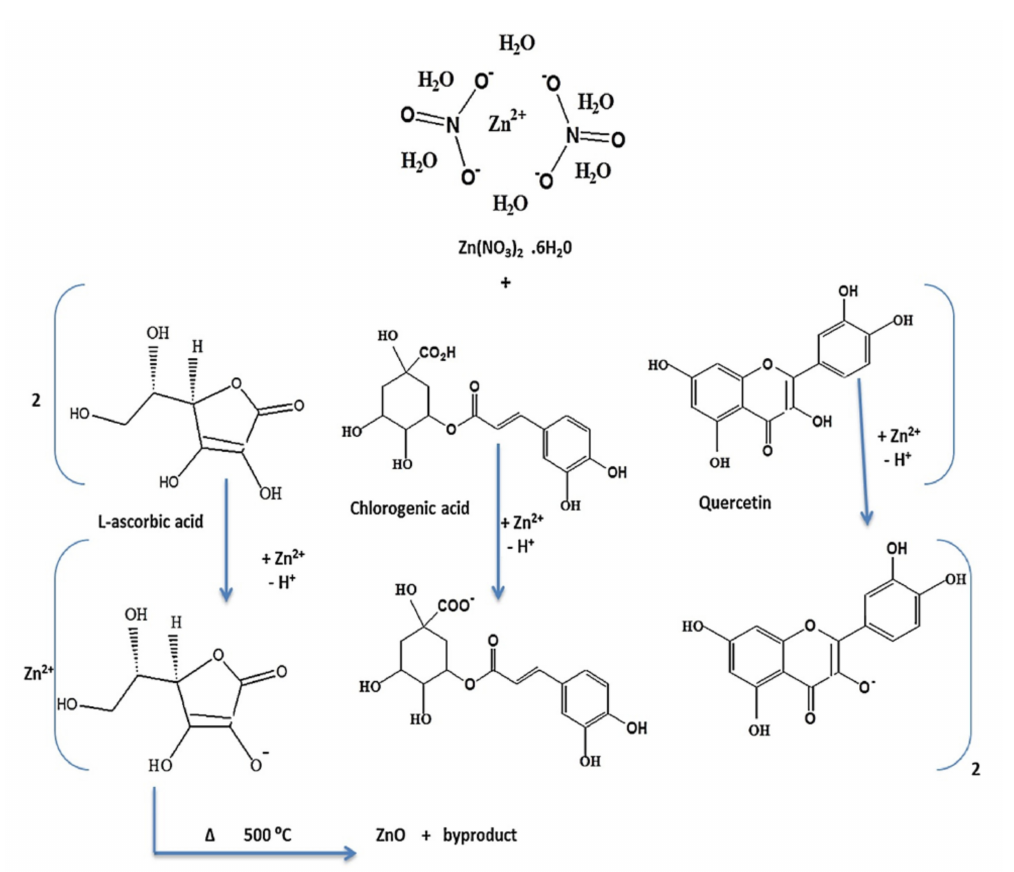
Figure 10. Mechanism of green synthesis of ZnO nanostructured material using plant